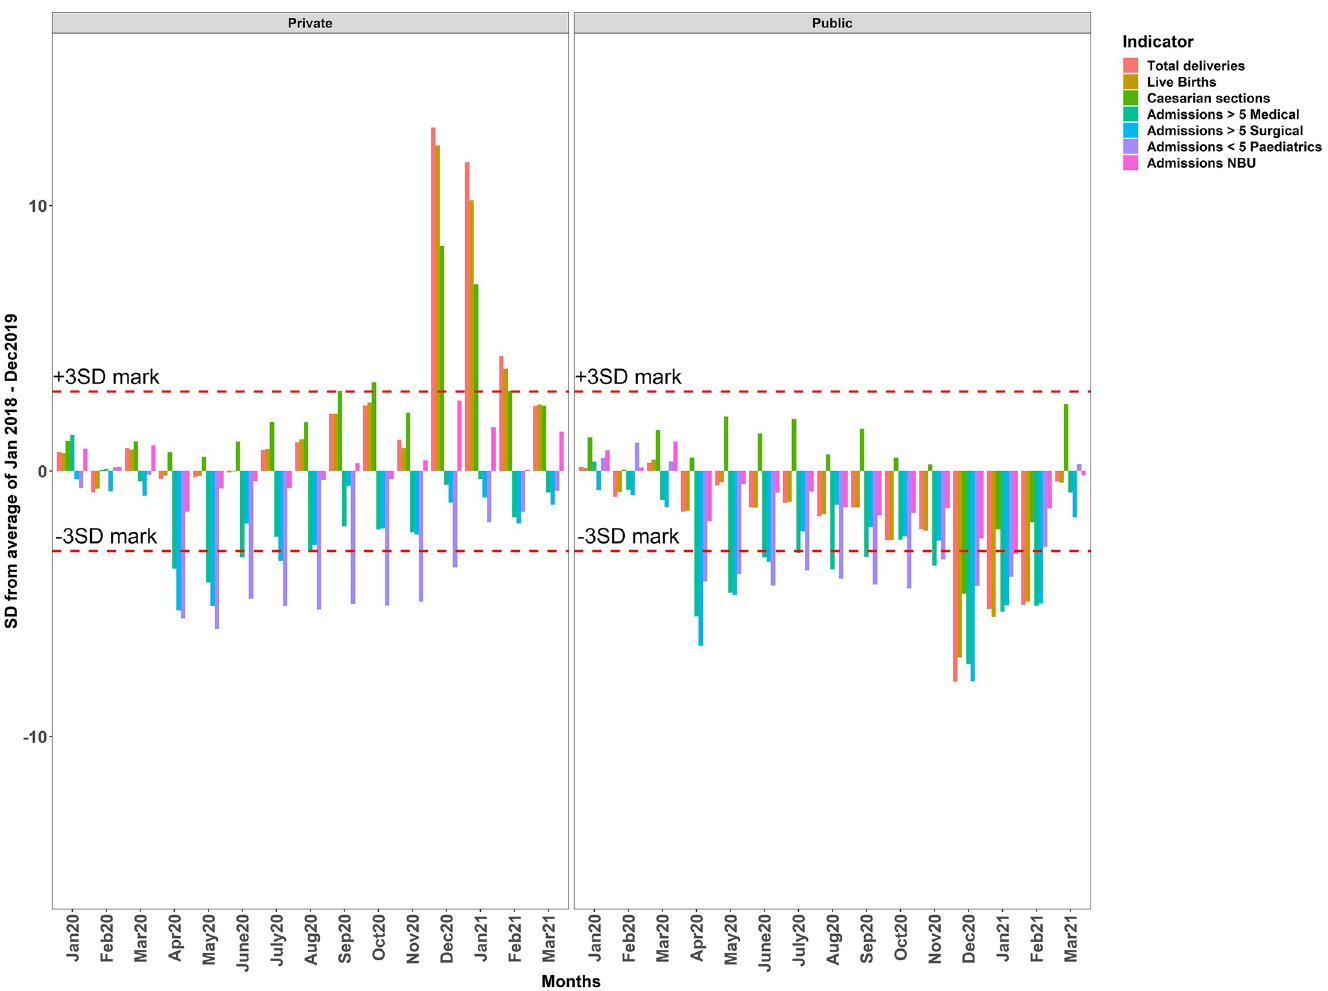
Fig 2. Statistical Process Control chart for both public and private hospitals. Horizontal dashed lines represent the 3-standard deviation